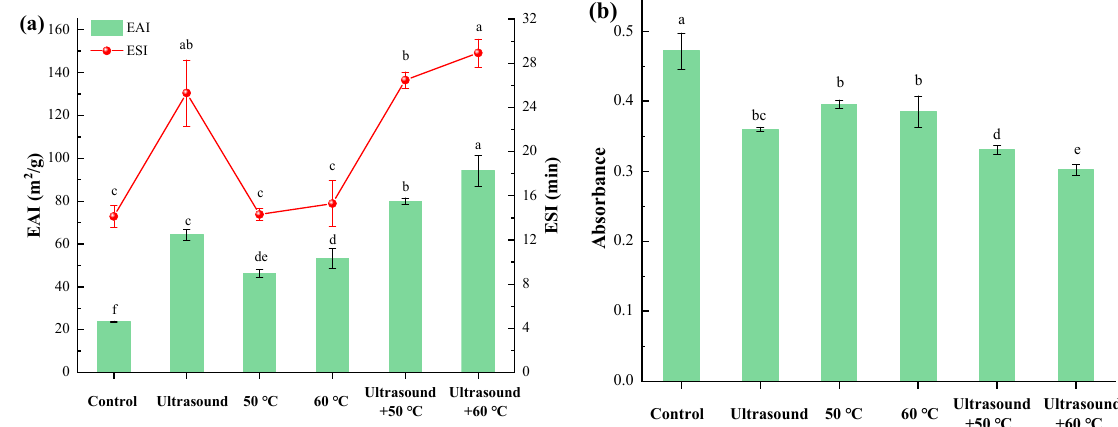
Figure 6. Effects of mild heating, mild heating combined with ultrasound and ultrasound treatments on emulsifying properties of 11S globulin ( a ) and free protein ( b ) ( p < 0.05, RM ANOVA, Duncan test).